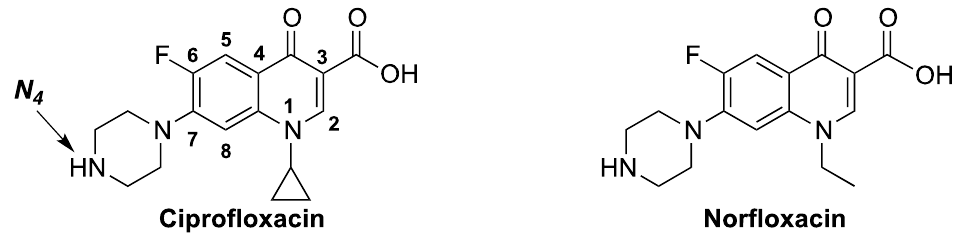
-substituted CIPRO and NOR derivatives 4